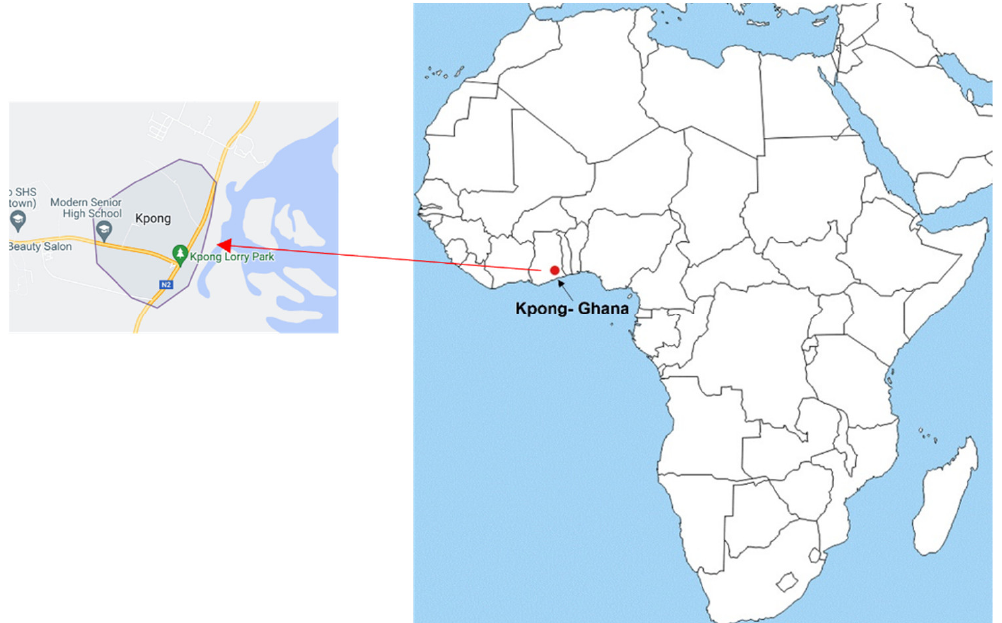
Figure 1. A map showing Kpong in Accra, Ghana (Latitude 6.160649° and Longitude 0.058329°).